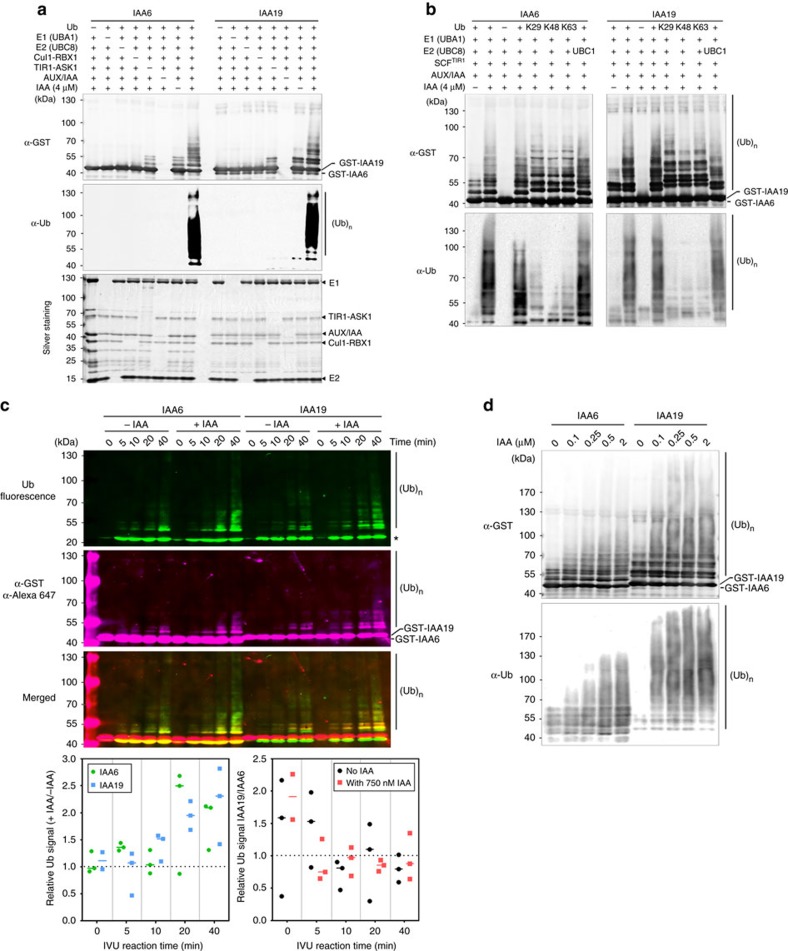
SCFTIR1-dependent and specific IAA6 and IAA19 ubiquitylation is enhanced by auxin.(a) IVU assays with recombinant GST-IAA6 or GST-IAA19, E1 (AtUBA1), E2 (AtUBC8), reconstituted SCFTIR1 (AtSKP1-TIR1, HsCul1 and MmRBX1), AtUb and IAA (auxin). AUX/IAA ubiquitylation is dependent on each component. Anti-GST, as well as anti-Ub antibodies recognize IAA6 and IAA19 ubiquitylated species. IVU reaction time 10 min (b) UBC8 and UBC1 Ub-conjugating enzymes (E2s) elicit poly-Ub-conjugation of IAA6 and IAA19 after 10 min in vitro. UBC8 promotes various Ub-linkages as seen by the reduction of IAA6 and IAA19 ubiquitylated species using either one of the chain-specific Ub-donors, Lys-29, Lys-48 or Lys-63 (Supplementary Fig. 9). (c) Rapid IVU of IAA6 and IAA19 is auxin- and time-dependent. Time course IVU reactions were performed using fluorescein isothiocyanate-labelled ubiquitin with or without 750 nM IAA. Ubiquitylation was monitored using the ubiquitin fluorescent signal (green, top) and Alexa Fluor 647-conjugated secondary antibodies for detection of GST:AUX/IAAs (magenta, middle). (*) Asterisk depicts ubiquitylated Cullin1 as previously reported79. ImageQuant TL software was used for quantification and generation of merged image (bottom). Ratios for auxin- and target-dependent ubiquitylation were calculated from three independent IVUs (n=3; see Supplementary Fig. 8b–d for replicates) and the single measurements are depicted in the corresponding scatter dot plots with line at median. A two-way ANOVA (P>0.05) showed no significant differences for the relative Ub signal between IAA6 and IAA19 in a specific time point (left), or for the IAA19/IAA6 ratio with or without 750 nM IAA. (d) Increased nanomolar concentrations of IAA promote IAA6 or IAA19 ubiquitylation after 10 min IVU reactions and higher molecular ubiquitylated species occurred on IAA19.